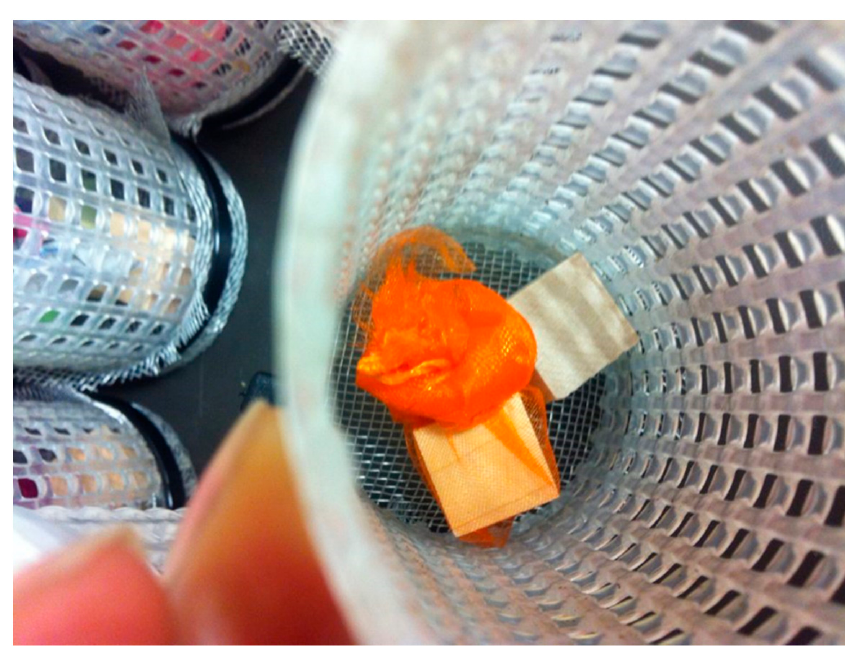
Figure A1. Seen here are cylindrical core mesh tubes with 50 mm × 50 mm window openings. At the base of the cylindrical core are a pair of wood cubes derived from Acer rubrum. The pair is composed of one cube enclosed in a polyester mesh (–M), while the adjacent pair is void of polyester mesh +M.